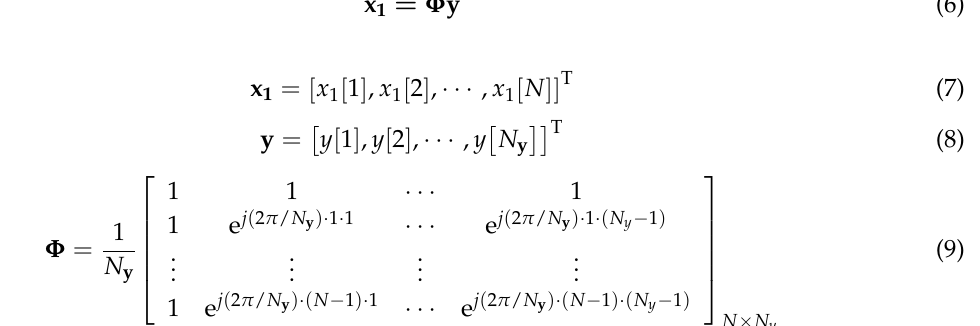
Figure 3. The effect of the subcarriers’ frequencies and phases on spectrum by performing FFT algorithm: ( a ) Subcarrier frequency spectrum ( 0)